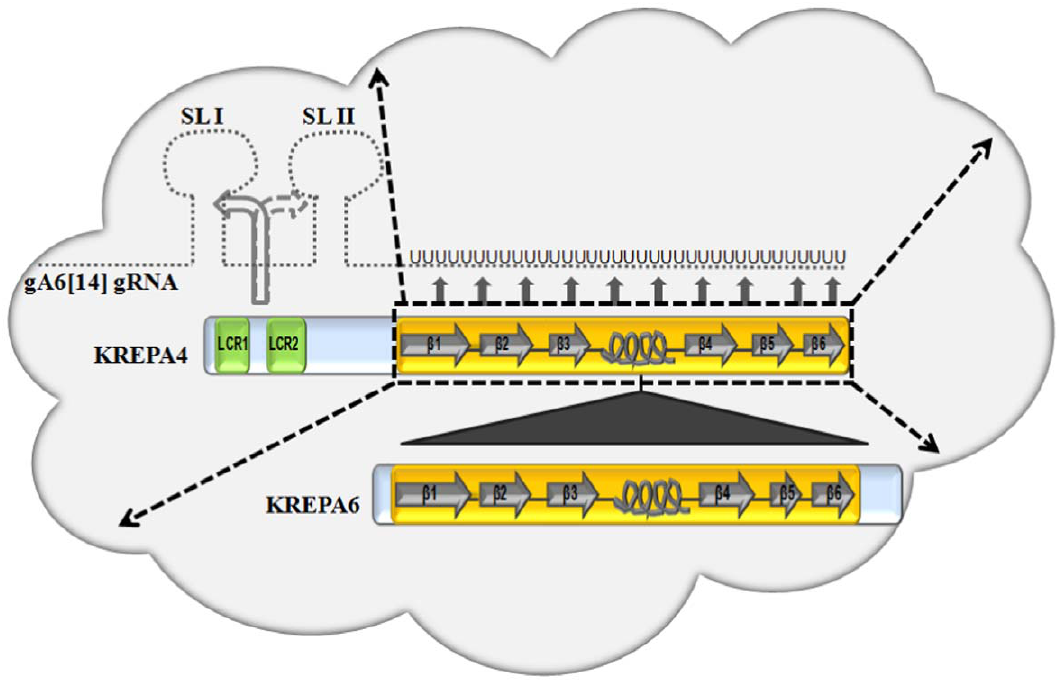
Figure 7. Proposed model for the RNA and protein interactions of KREPA4 in the 20S editosomes. The editosome complex is depicted in the form of a cloud. Full length KREPA4 and KREPA6 proteins are shown as a part of the complex. The secondary structure of their OB-folds is represented schematically. Based on the current in vitro studies, the a -helix of the KREPA4 OB-fold is shown to interact directly with KREPA6 (filled triangle), while the entire OB-fold is shown to form stable associations with the editosome complex (thick, dashed arrows). In addition, based on previous in vitro RNA binding studies, the OB-fold of KREPA4 also mediates a high-affinity binding to the gA6 [14] gRNA oligo(U) tail (filled arrows), and this contact is stabilized by the LCRs through sequence-specific interactions with the guide stem–loop elements (curved arrows) [46]. The interaction of KREPA4 with stem–loop I (SL I) is preferred over that with stem–loop II (SL II) and is indicated by a solid curved arrow versus a dashed curved arrow, respectively. The oligo (U) tail of the gRNA is extended to fit the